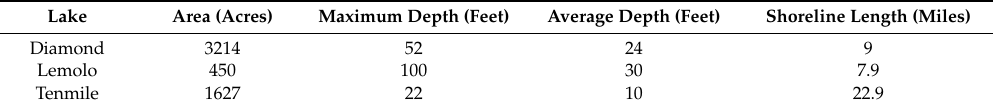
Figure 2. Map of the Lemolo Lake, Diamond Lake, and the Tenmile Lakes study areas. The larger image is a Landsat image from 15 July 2014. The inset image is from Google Earth. Table 1. General characteristics of Diamond Lake (North Umpqua Watershed), Lemolo Lake (North Umpqua Watershed), and Tenmile Lakes (Tenmile Creek Watershed) in Oregon. Source: Reference [42].